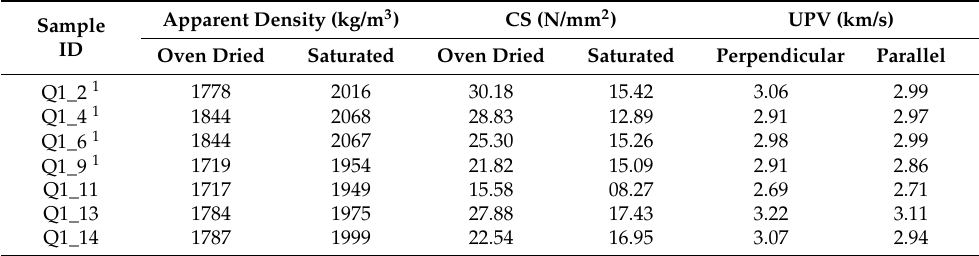
Table 7. Petrophysical